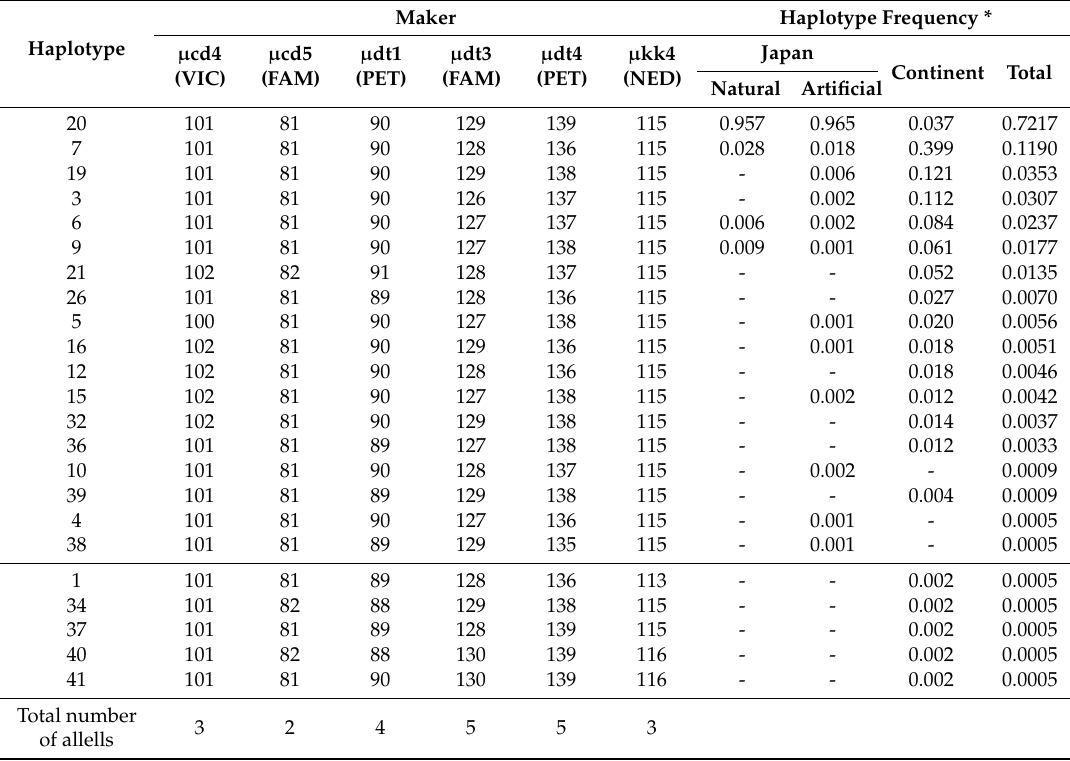
Table 2. The 23 chloroplast haplotypes revealed by the six simple sequence repeat (SSR) markers and the fragment length of each marker, and frequency of each